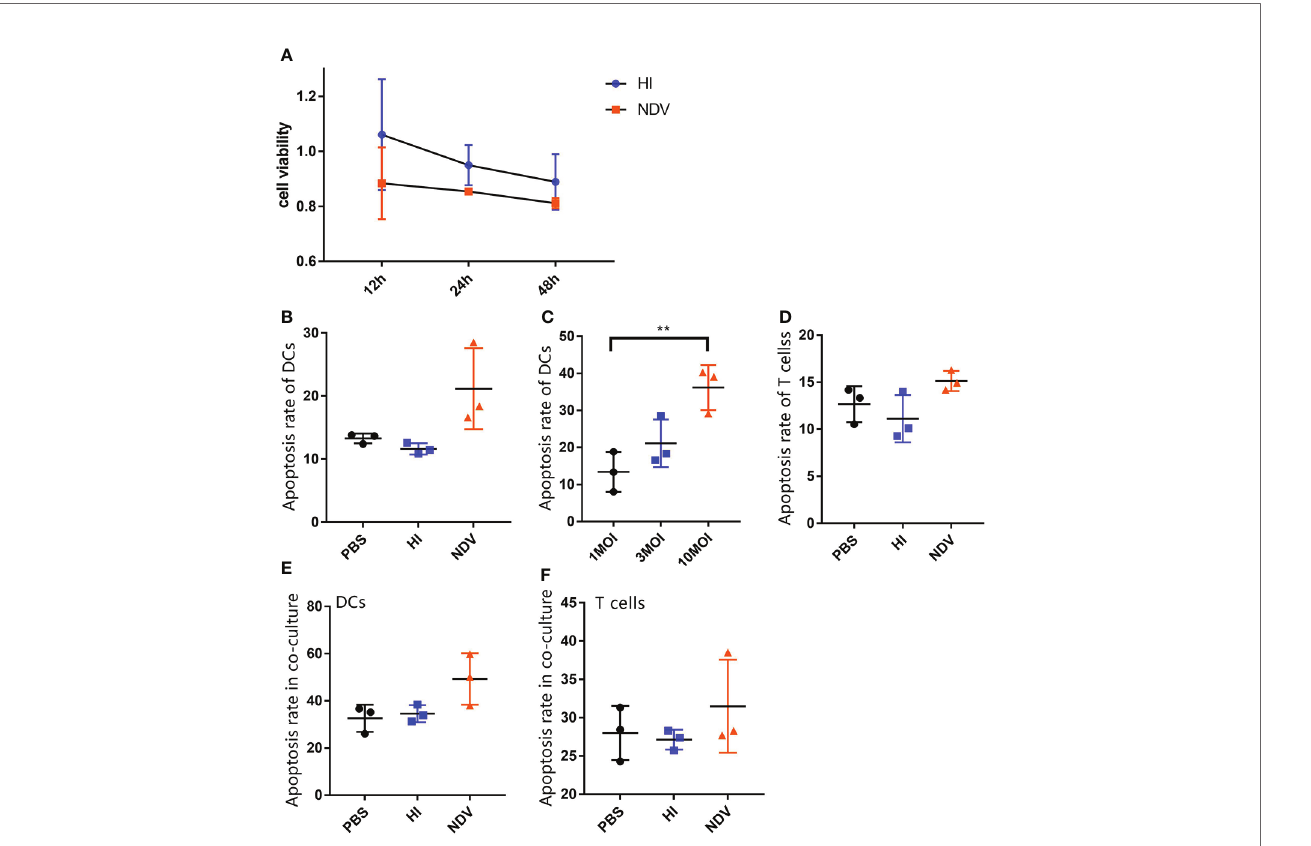
FIGURE 3 | Flow cytometry analysis of apoptosis of DCs and T cells. Cell viability of treated DCs were measured using CCK-8 (A) . Treated cells were stained with FITC-annexin V and PI, and then apoptosis rates of infected DCs (B) and T cells (D) at 3 MOI or indicated MOIs (C) were analyzed by fl ow cytometry. Treated DCs were co-cultured with T cells and then apoptosis rates of DCs (E) or T cells (F) in co-cultures were measured. All experiments were performed independently at least thrice and results were presented as means ± standard deviation. Signi fi cance level was de fi ned as **p <